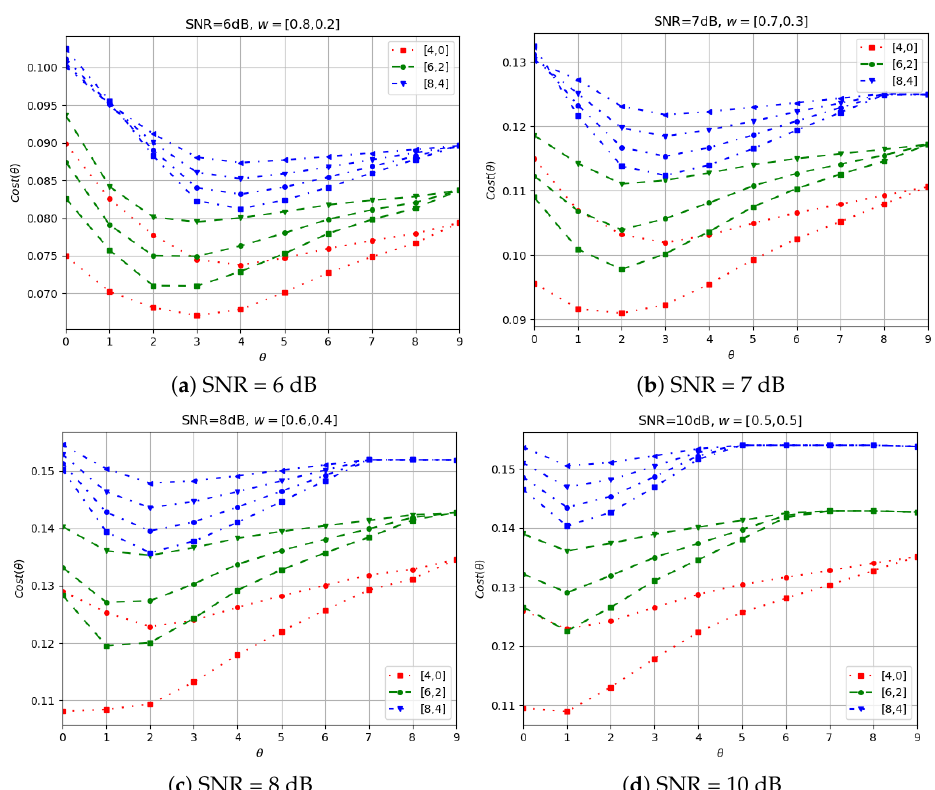
Figure 11. Cost functions for various N (indicated by color), d (indicated by marker): ( a ) w = [ 0.8,0.2 ] , ( b ) w = [ 0.7,0.3 ] , ( c ) w = [ 0.6,0.4 ] , ( d ) w = [ 0.5,0.5 ] .